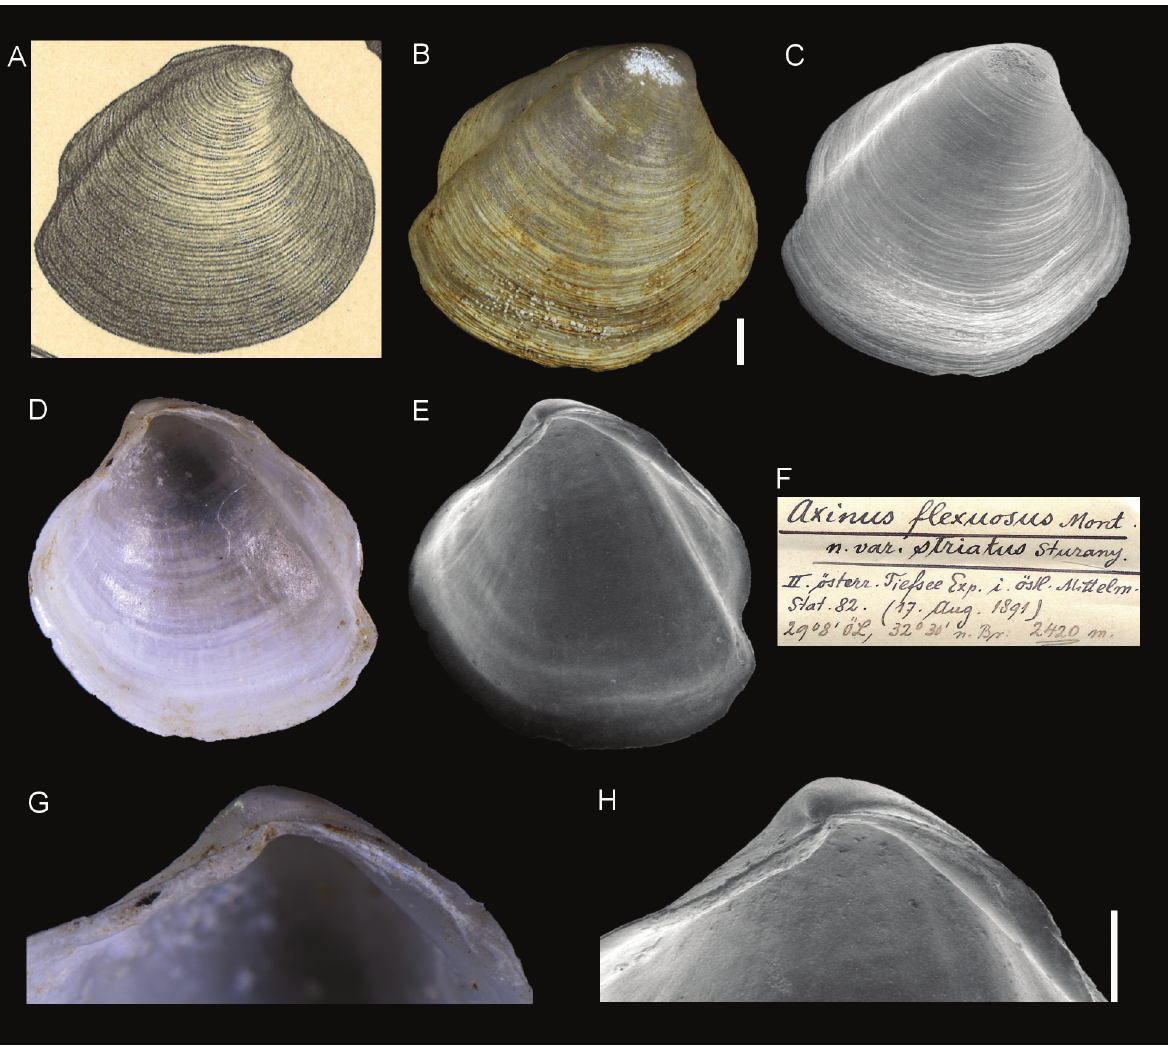
Figure 12. Axinus flexuosus var. striatus Sturany, 1896, station 82, north of Alexandria, Egypt, 2420 m. A . Original figure in Sturany, 1896. B–E , G , H . Holotype NHMW 13009: outer ( B–C ) and inner ( D–E ) views, hinge ( G–H ). F . Original label. Scale bar: 1